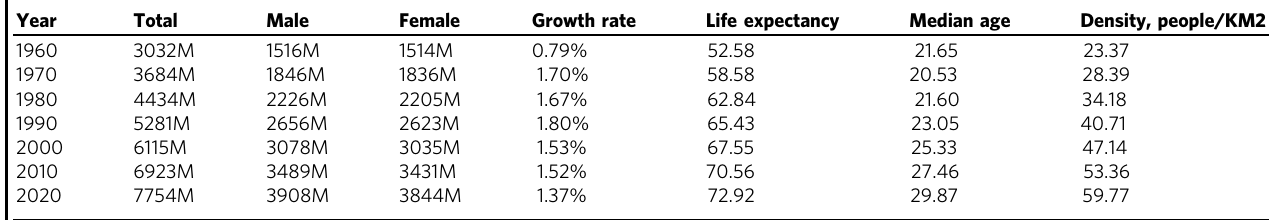
Table 3 World Population history from 1960 – 2020.